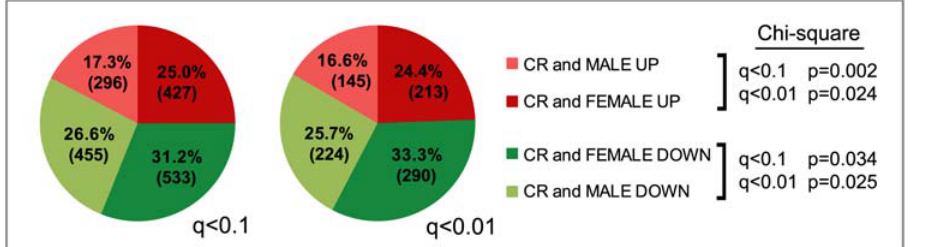
Figure 4. CR feminizes overall gene expression. Fractional distributions of all genes changed by CR and which display sexually dimorphic expression in the data of Yang et al. Percent numbers are percent of all genes displaying both specific directional changes from CR and sexually dimorphic expression and corresponding numbers of genes in each of these four classes are given in parentheses. Deviation from expected frequencies was determined by a chi-square test for upregulated genes and separately for downregulated genes, at each q-value cutoff.